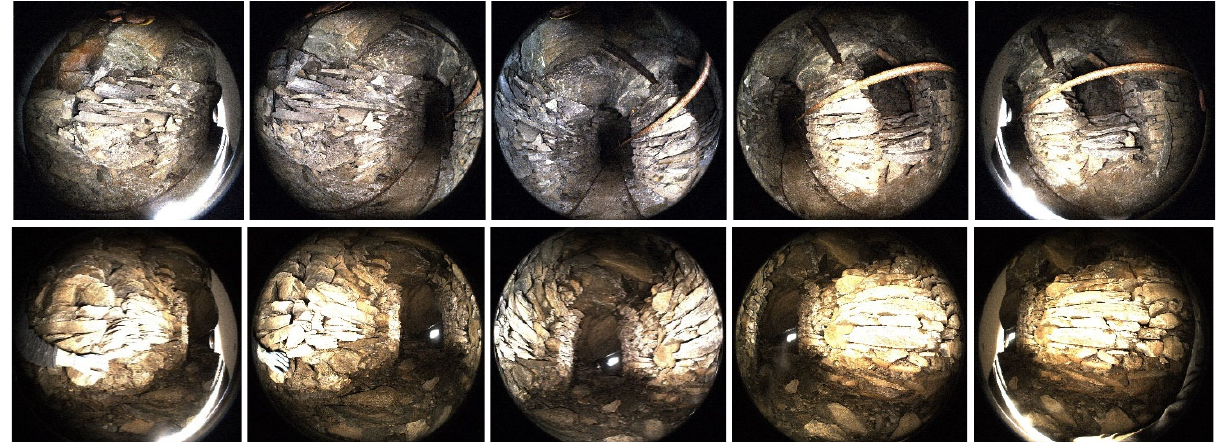
Figure 4. Two multi-images taken by the Ant3D multi-camera